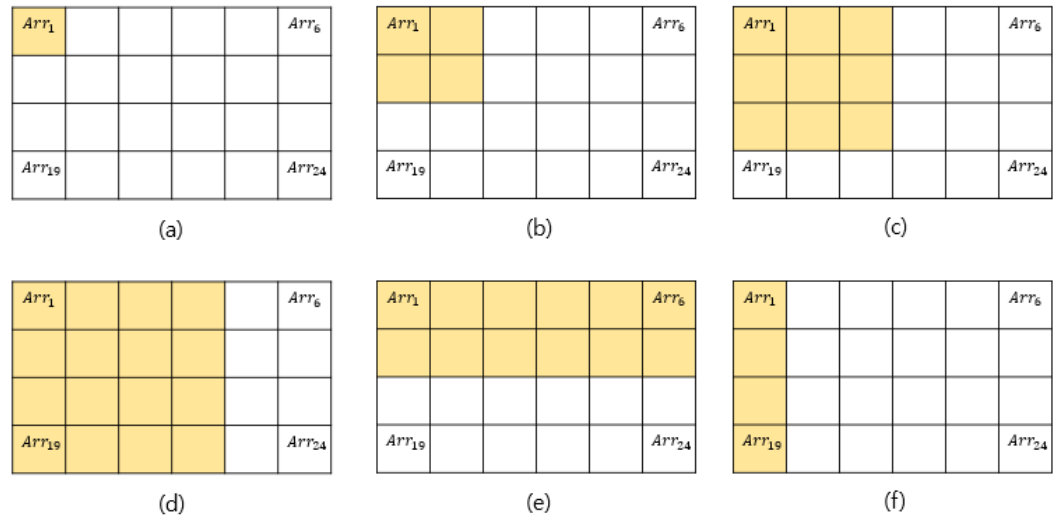
Figure 7. Range setting according to contact area: ( a ) size 1, ( b ) size 4–1, ( c ) size 9, ( d ) size 16, ( e ) size 12, ( f ) size 4–2.